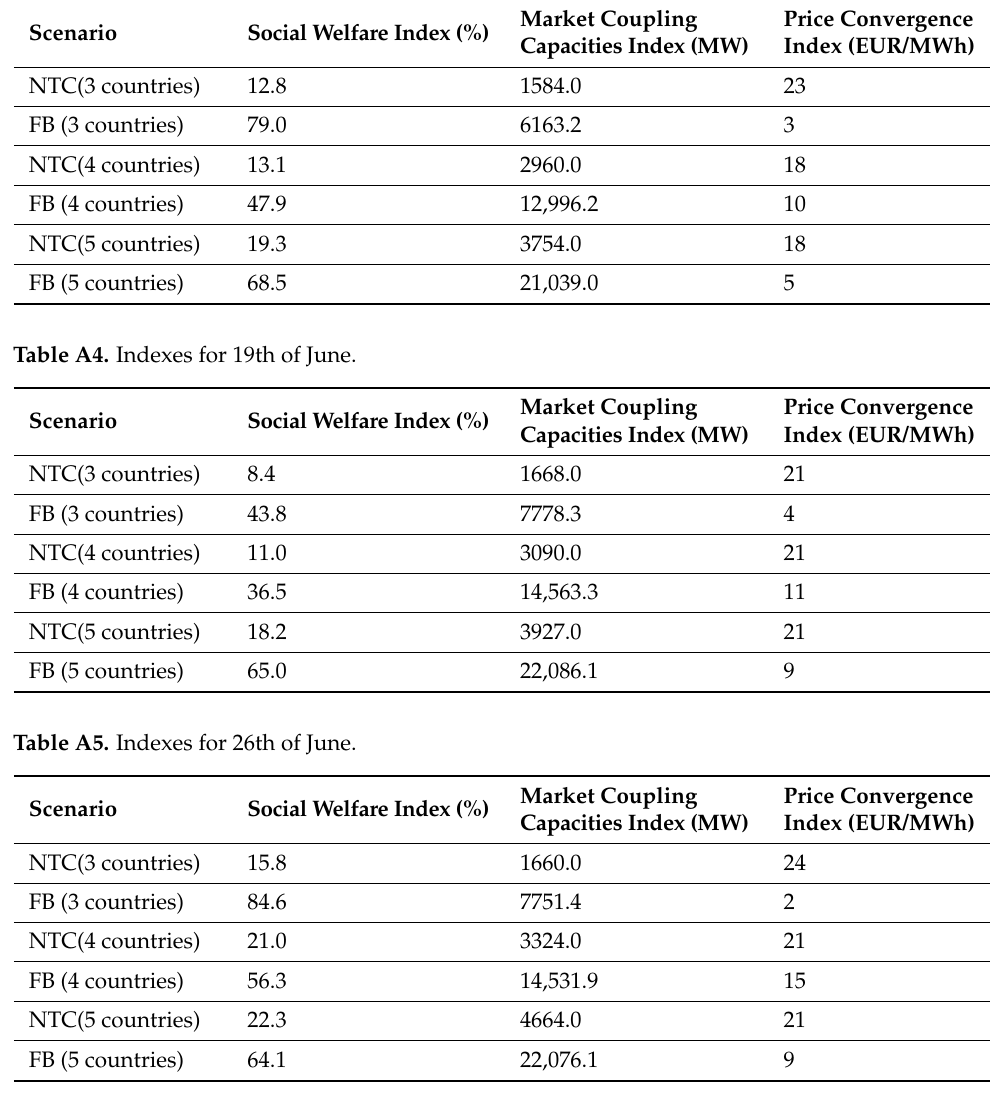
Table A3. Indexes for 12th of June.